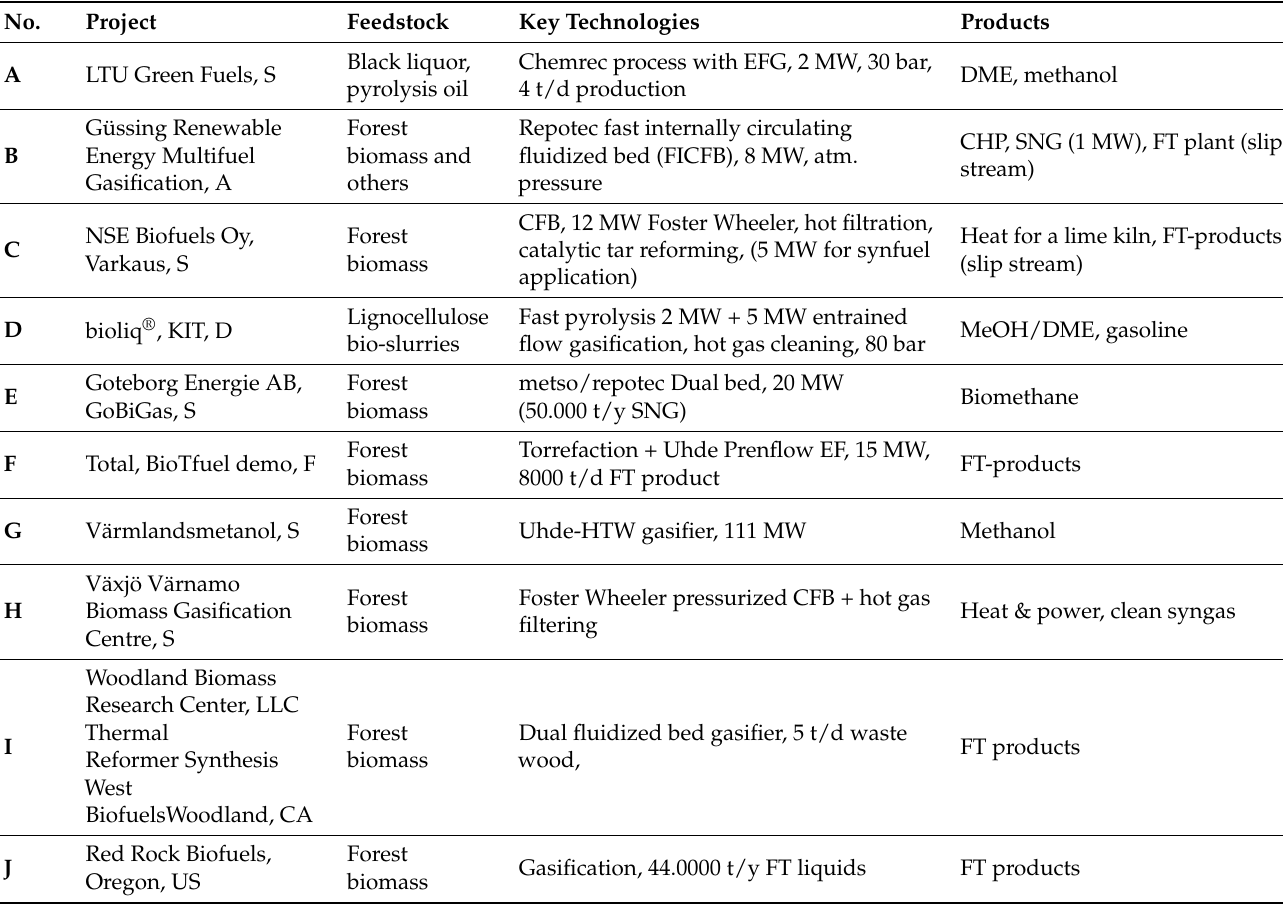
Table 1. Selected pilot or demo projects for biomass to liquid (BtL)